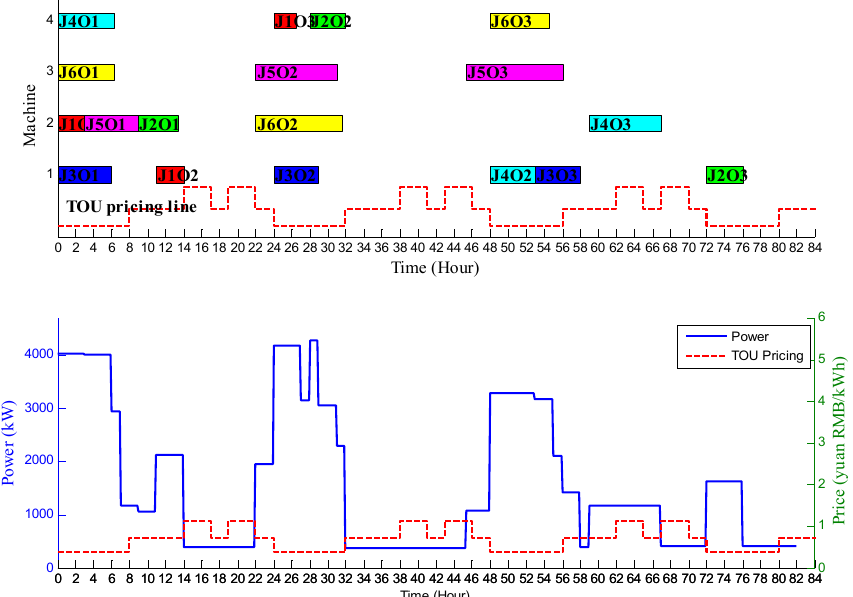
Figure 11. Gantt and power charts of the optimal solution to configuration C4 × 6& EDF.